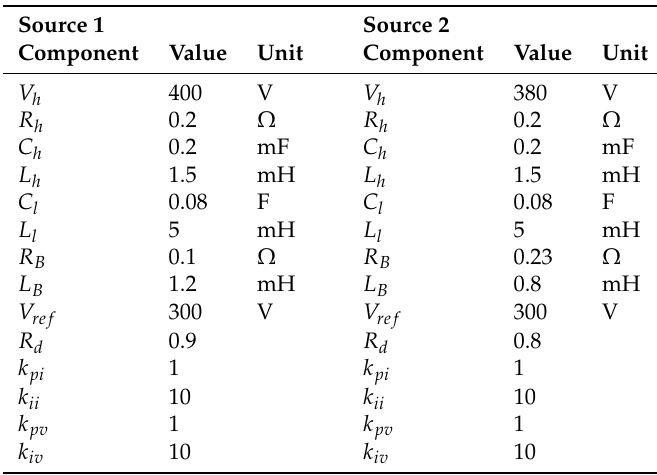
Figure 6. Hardware-in-the-loop schematic for the small microgrid example. Table 3. Source 1 and Source 2 parameter